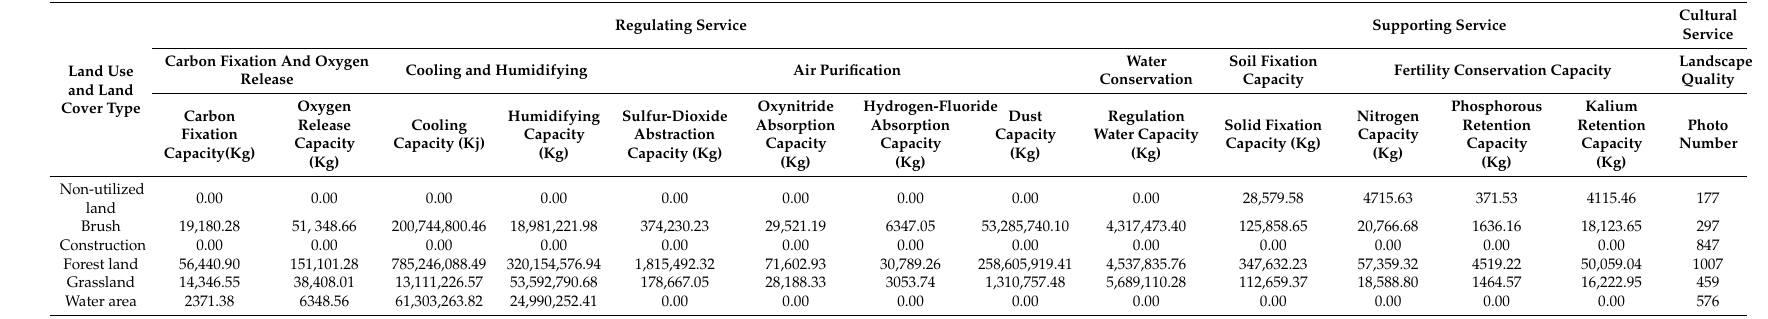
Table 2. Quality of ecosystem services of different land coverage types.